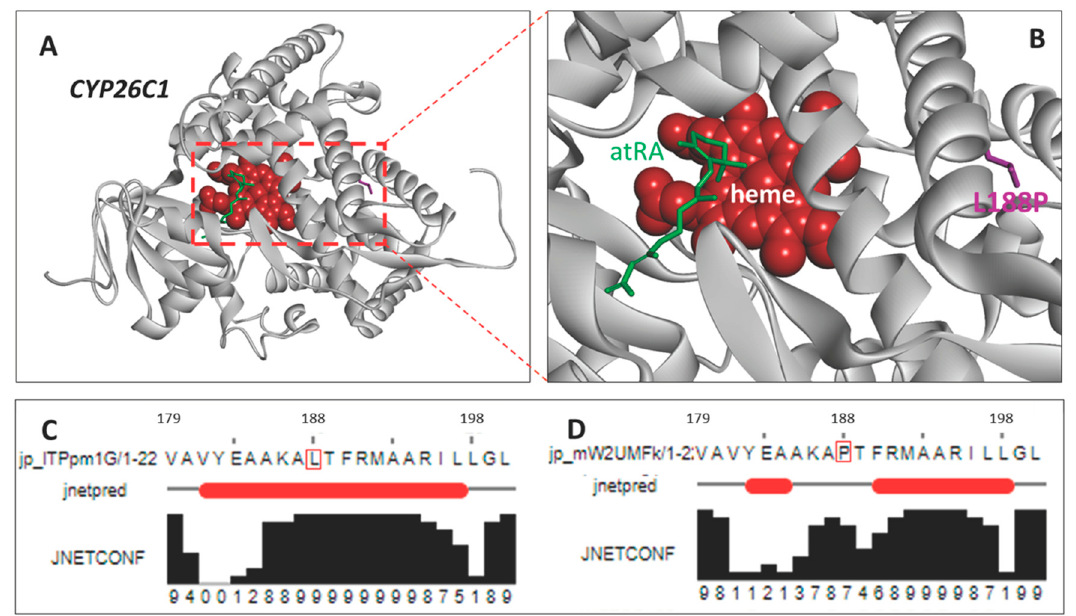
Figure 4. Structural modeling of cytochrome CYP26C1. ( A ). Three dimensional structural model of CYP26C1 ( B. taurus ) showing the heme in red ball, all trans-retinoic acid (atRA) in green stick and the L188P mutation in magenta stick. ( B ). The active site focused structure. ( C ). The secondary structure prediction of the wild-type L188 segment (positions 179–200). ( D ). The secondary structure prediction of the 179–200 segment with the L188P mutation. In ( C , D ), the red bars (jnetpred) indicate the predicted position of a helix, which is broken in the presence of the L188P mutation. Confidence in the predicted structure (JNETCONF) is displayed by vertical black bars .